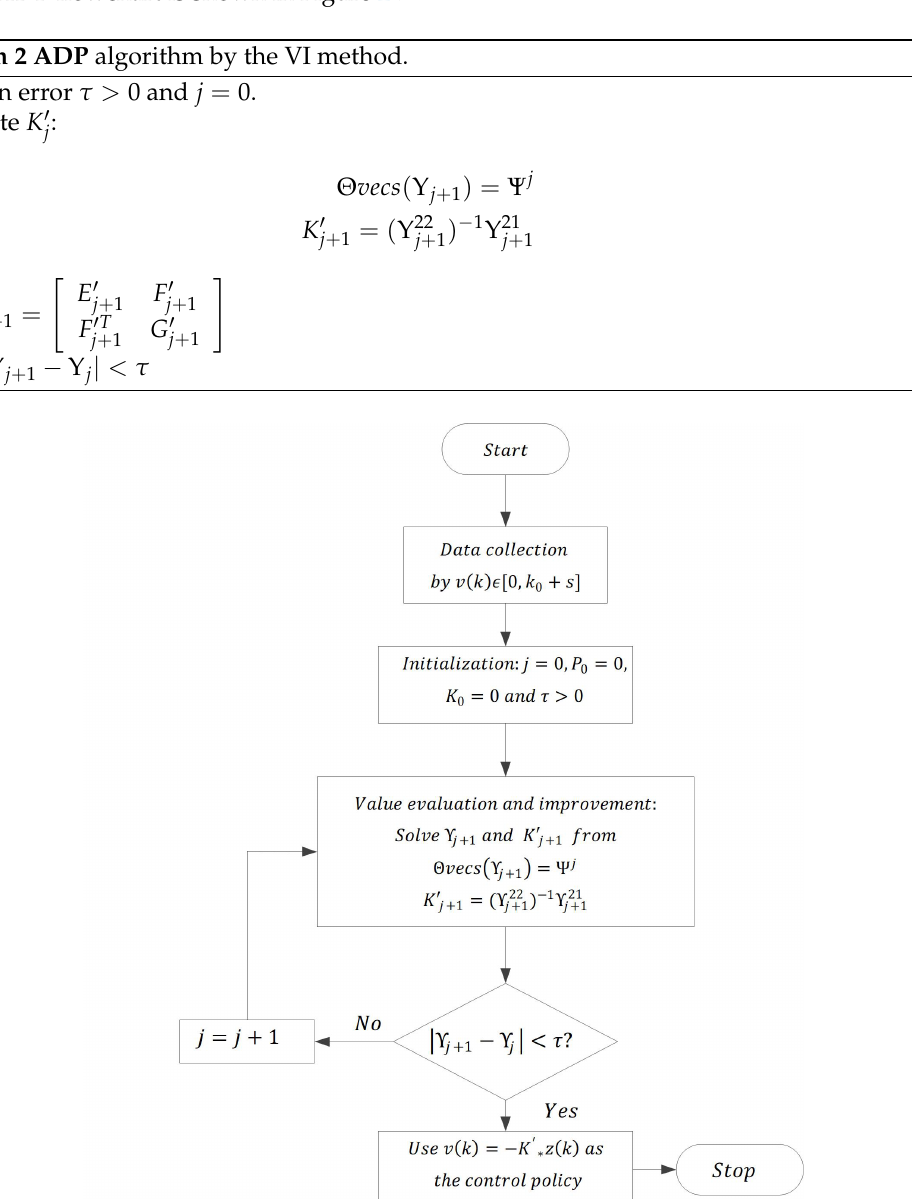
Figure 2. ADP algorithm by the VI method